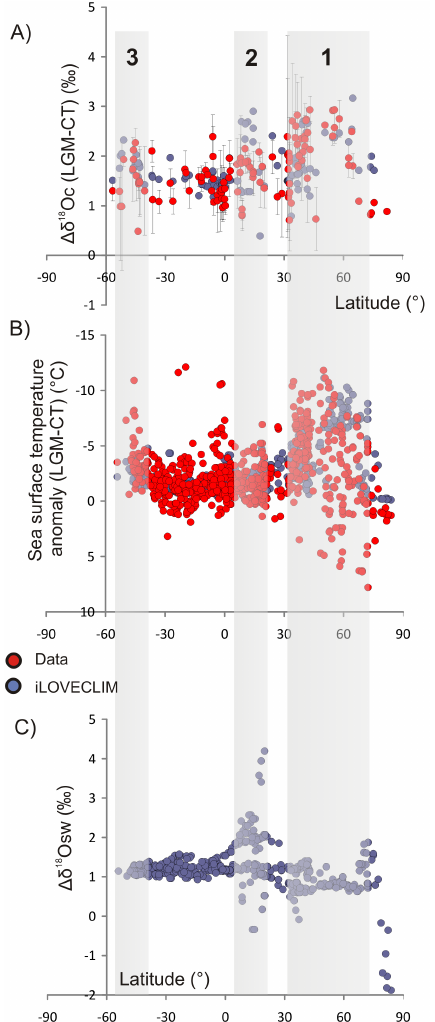
Figure 9. Data–model ( i LOVECLIM) comparison as a func- tion of latitude for (a) the surface ocean (0–50m) calcite δ 18 O anomaly (LGM-CT) and (b) sea surface temperature anomaly (LGM-CT). (c) Simulated surface water δ 18 O anomaly (LGM-CT) in i LOVECLIM as a function of latitude (model results are taken at the same location as sea surface temperature data). Grey bands de- note large positive calcite δ 18 O anomaly in (1) the North Atlantic, (2) the North Indian Ocean and (3) the Southern Ocean as discussed in the text.